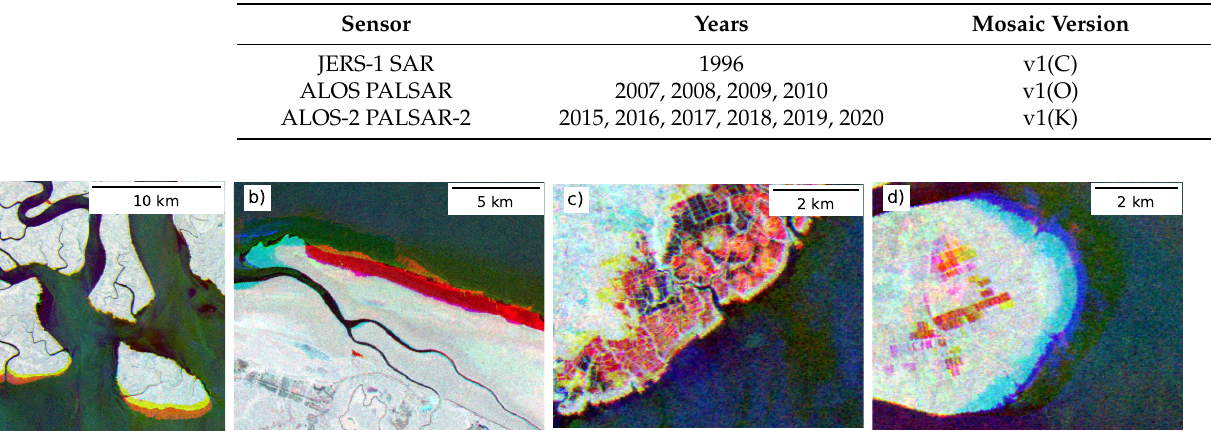
Figure 2. Examples of mangrove change identified within a time-series composite of L-Band HH SAR data from 1996, 2010 and 2020 in RGB. Areas in red and yellow highlight loss of mangroves (high L-HH in 1996 but low in later years = red; L-HH is high in 1996 and 2007 but low in 2010 = yellow) while gains are represented by shades of blue (i.e., low L-band HH backscatter in 1996 but increased in both 2010 and 2020 (cyan) and in 2020 only (blue)). Examples of change are mangrove loss and/or gain in ( a ) the Sundarbans, ( b ) French Guiana, ( c ) Sulawesi (Indonesia) and ( d ) Sumatra (Indonesia). Observed losses are primarily through coastal erosion ( a , b ) and deforestation (e.g., for aquaculture development ( c ) whilst gains are primarily through colonisation of coastal sediment banks ( b , d